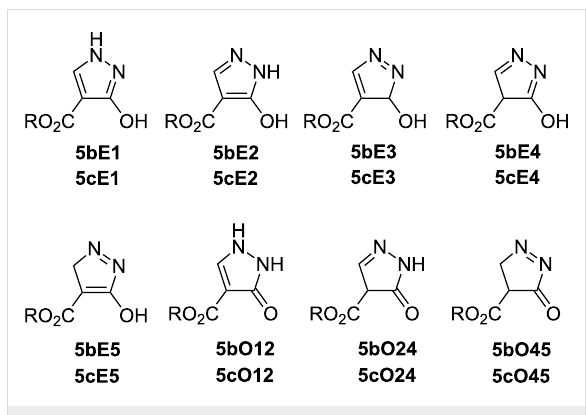
Figure 2: Tautomers of 5b (R = Me), 5c (R = Et).